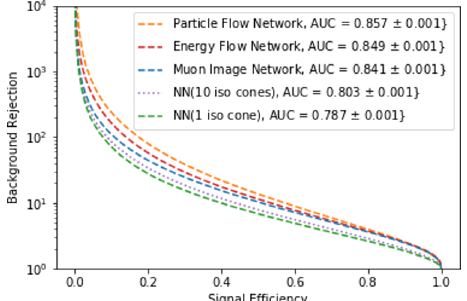
Figure 4. Background rejection versus signal efficiency for Particle-Flow networks trained on lists of calorimeter deposits (orange, dashed), Energy-Flow networks trained on lists of calorimeter deposits (red, dashed), convolutional networks trained on muon images (blue, dashed), networks trained on a set of isolation cones (purple, dotted) and the benchmark approach, a single isolation cone approach (green,